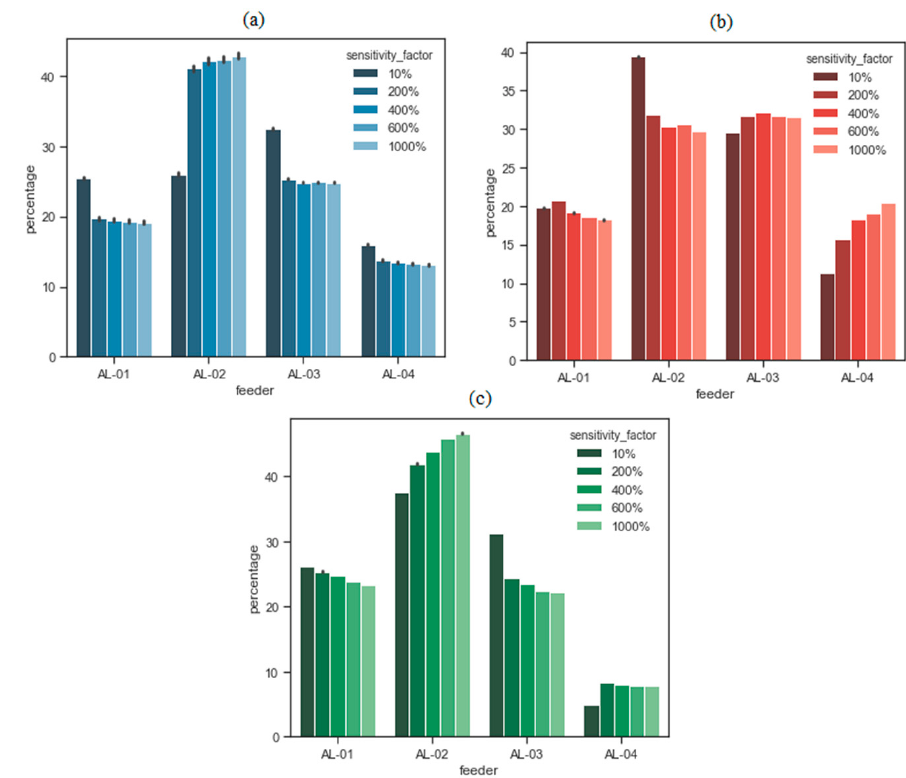
Figure 8. Analysis of the sensitivity factor per feeder in ( a ) phase A ( b ) phase B ( c ) phase C.